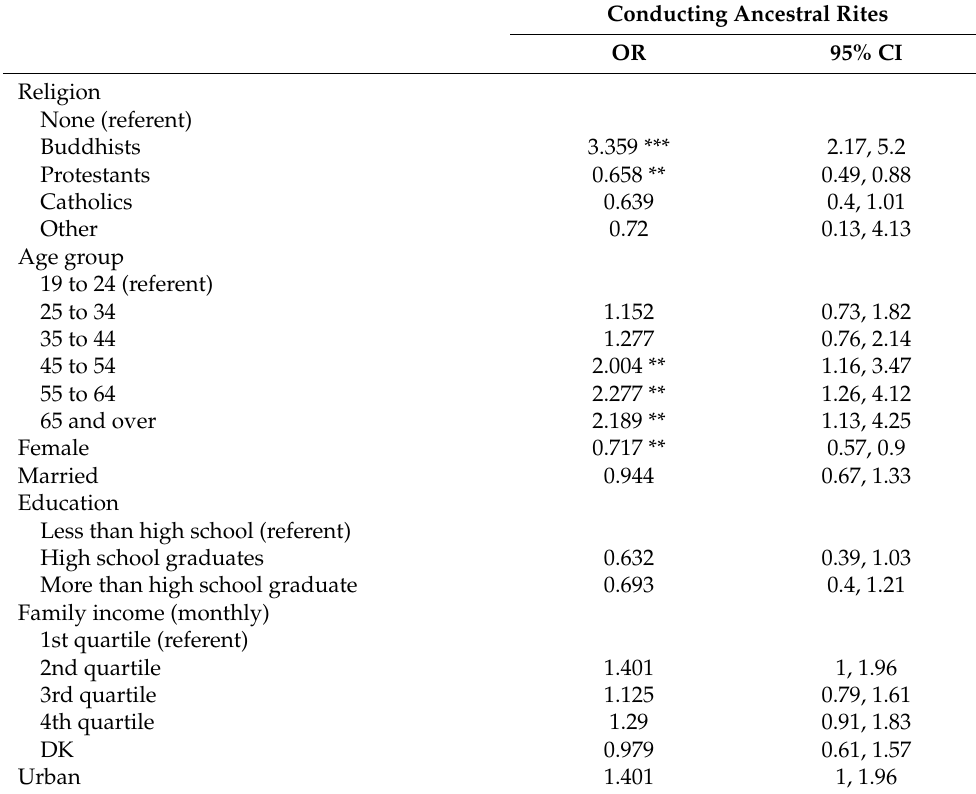
Table A3. Results of binary logistic regression on Confucian identification, beliefs, and practices (cont.). Conducting Ancestral